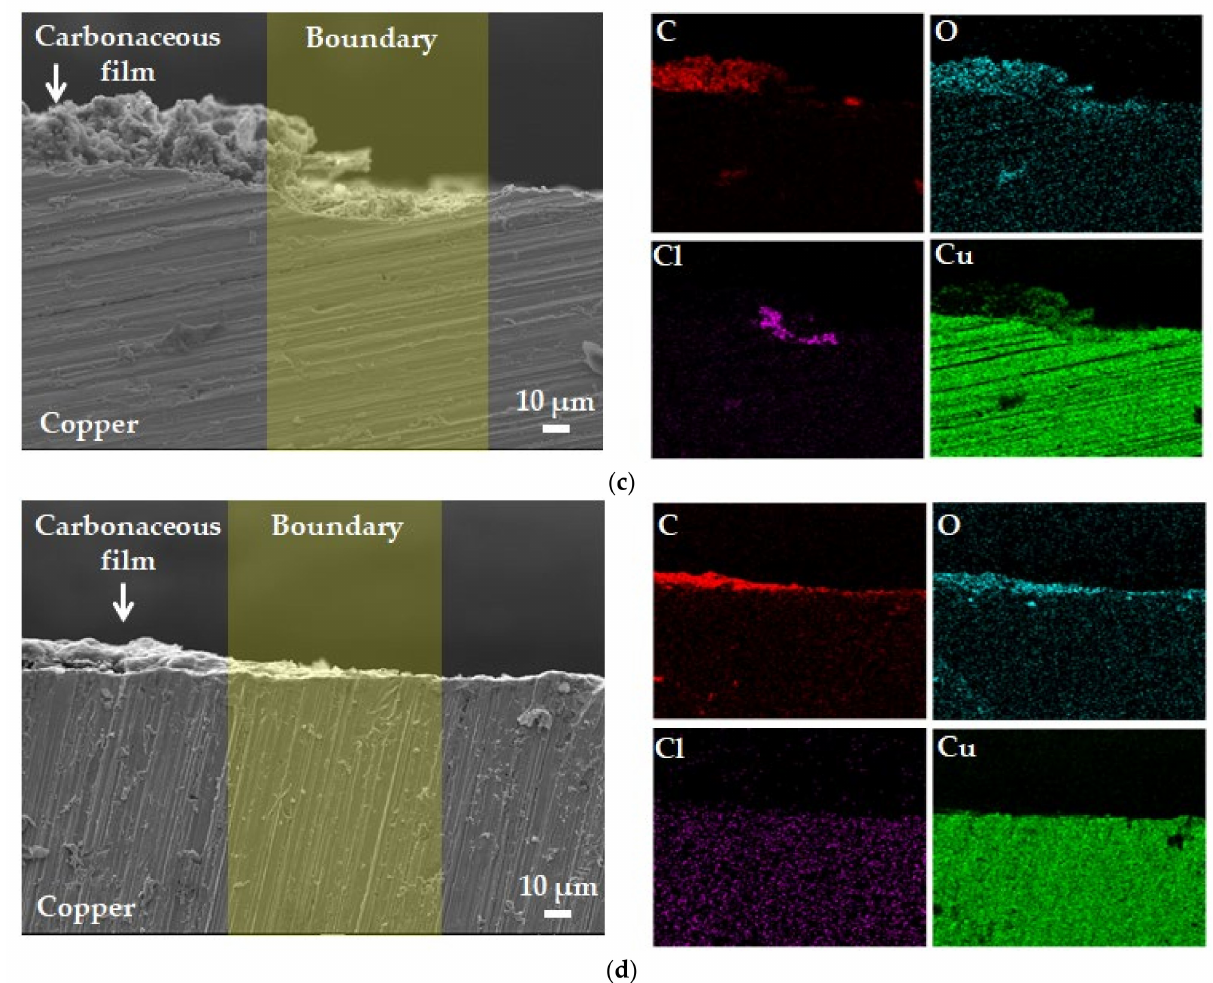
Figure 8. EDS mapping analysis of the copper-carbonaceous film boundary parts of specimen 2 after potentiostatic polarization test based on the presence or absence of BTA; ( a ) surface analysis of specimen 2 without BTA; ( b ) surface analysis of specimen 2 with BTA; ( c ) cross-section analysis of specimen 2 without BTA; ( d ) cross-section analysis of specimen 2 with